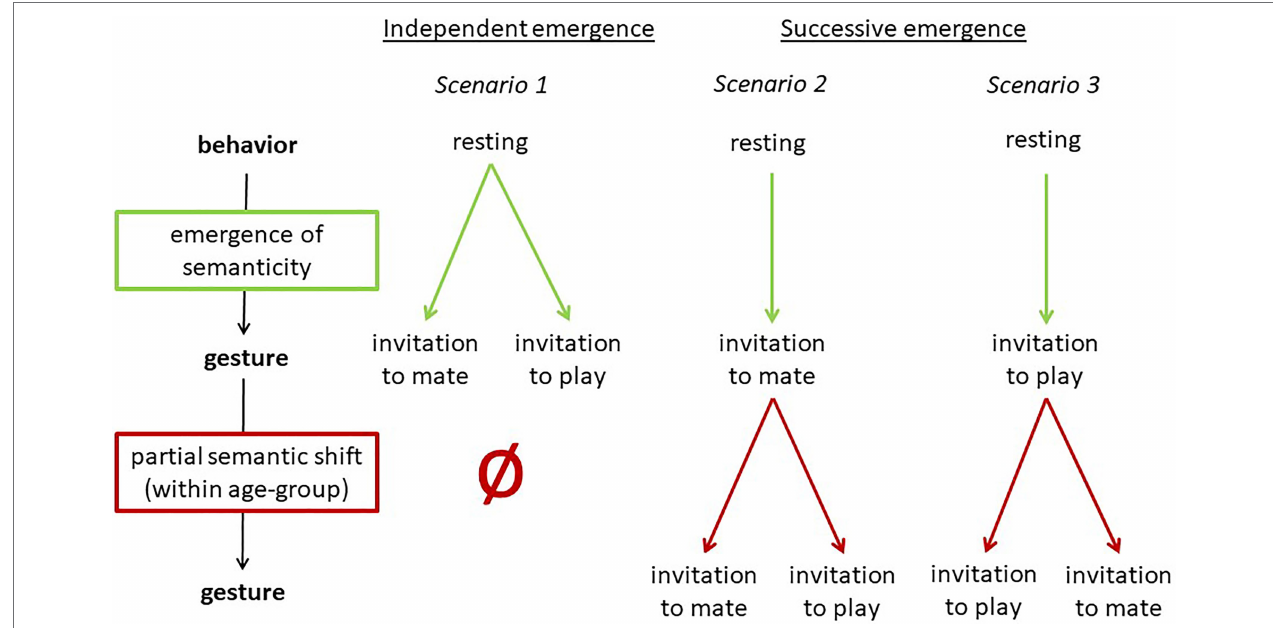
FIGURE 5 | Three scenarios for the emergence of PLAY-NEST BUILDING and MATING-NEST BUILDING in the Taï South